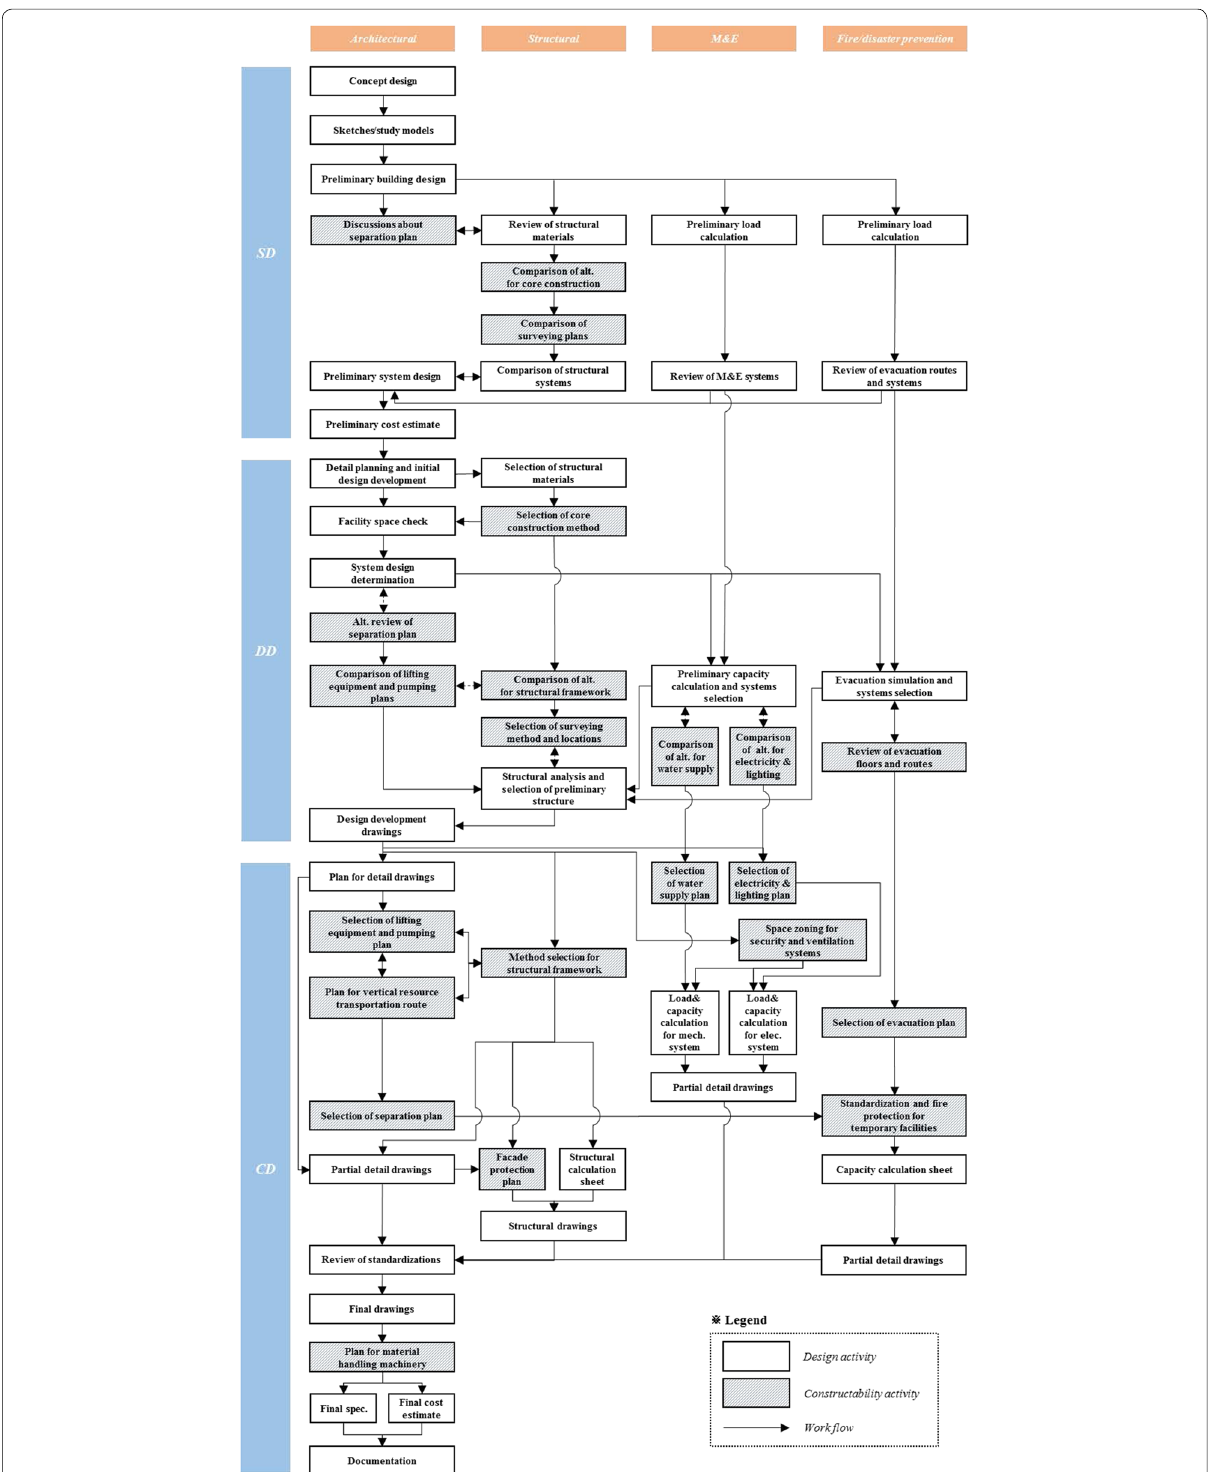
Fig. 3 Work process integrating constructability into the design